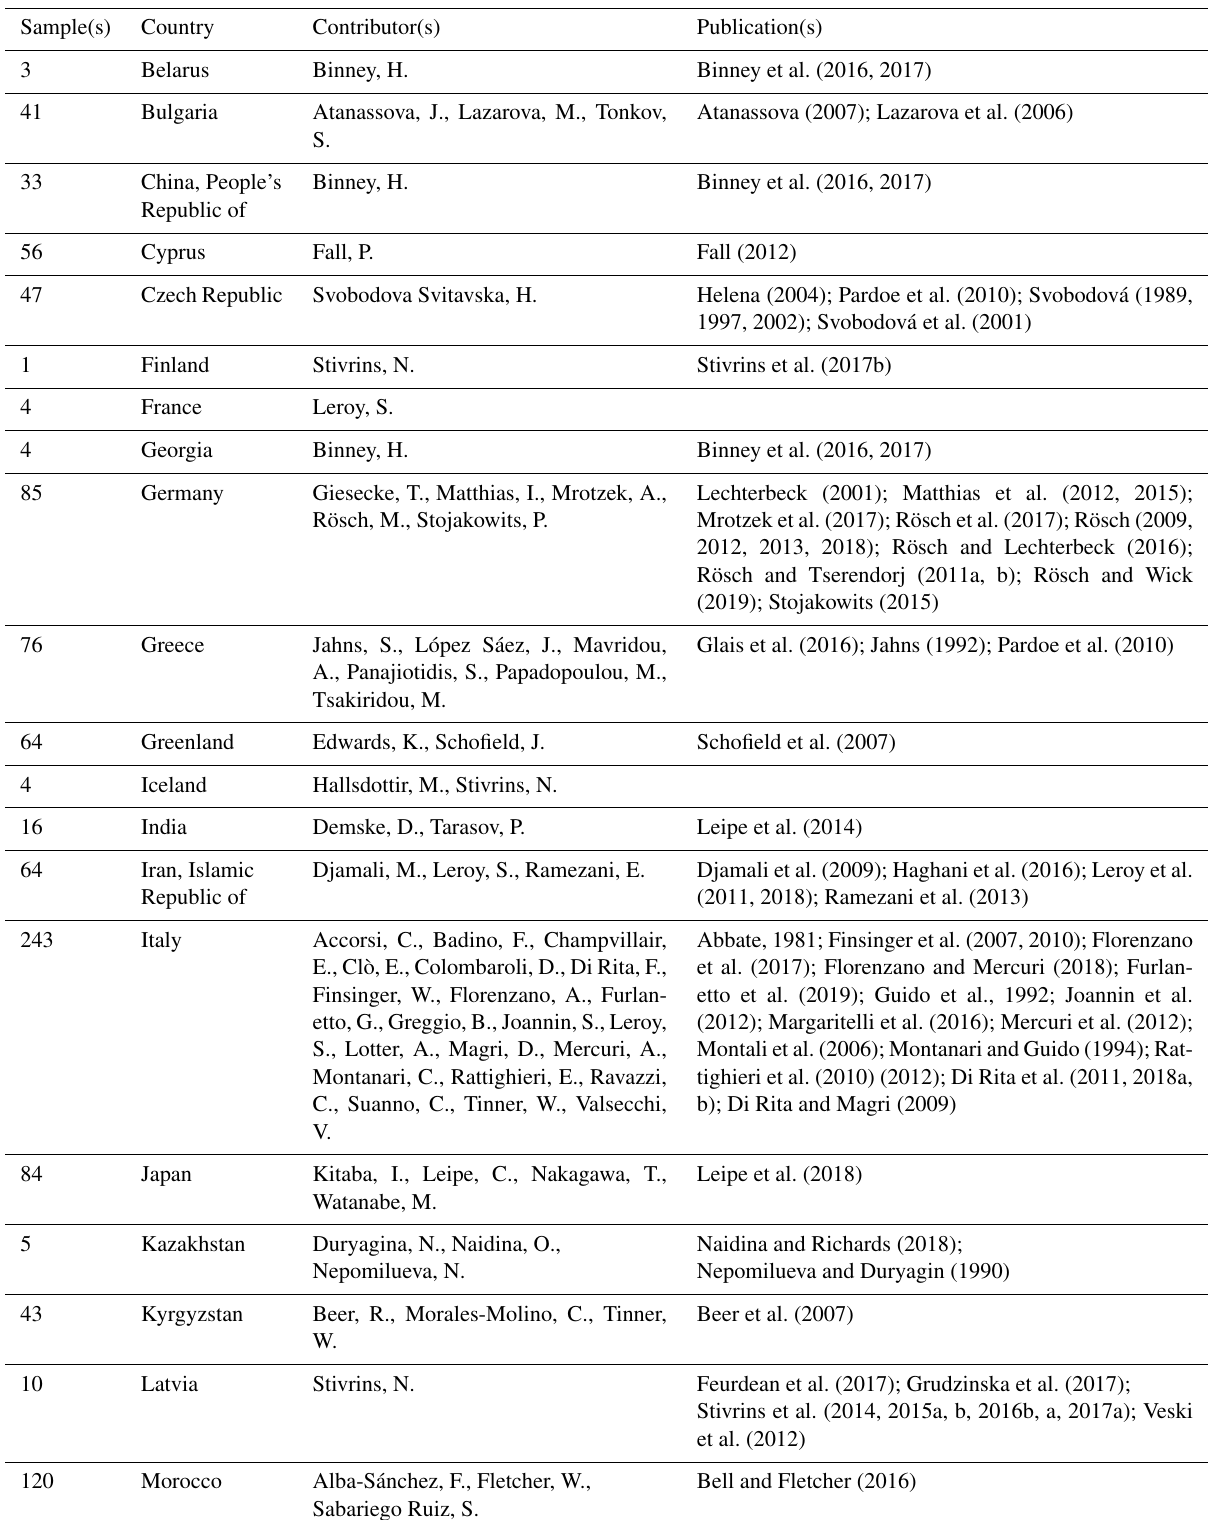
Table 2. List of data submitted to the EMPD2 by